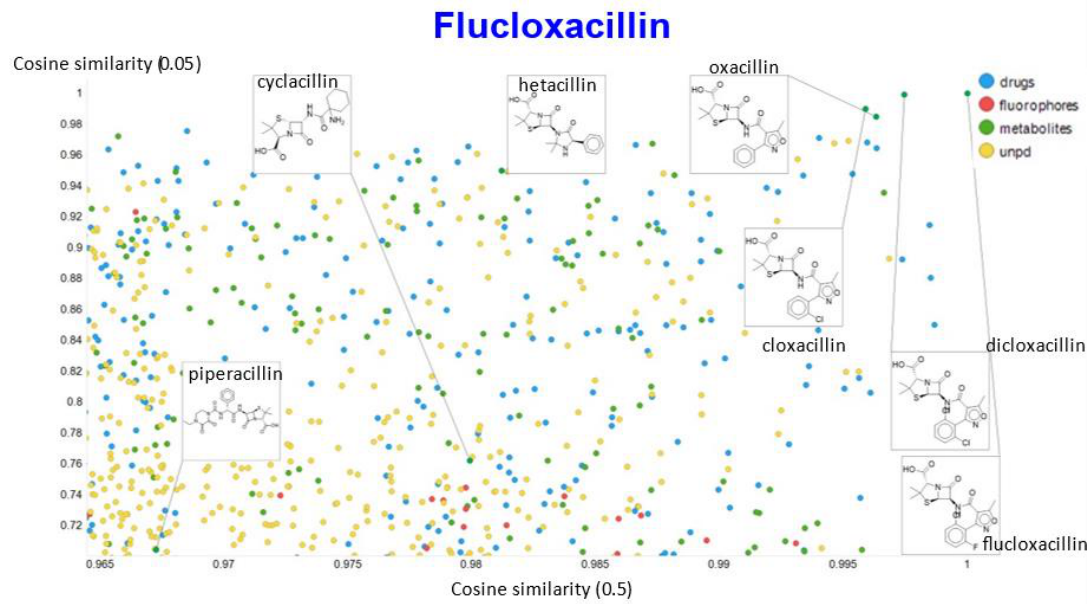
Figure 18. Relationship between cosine similarity for values of the temperature parameter of 0.05 and 0.5 for flucloxacillin in our chemical space.